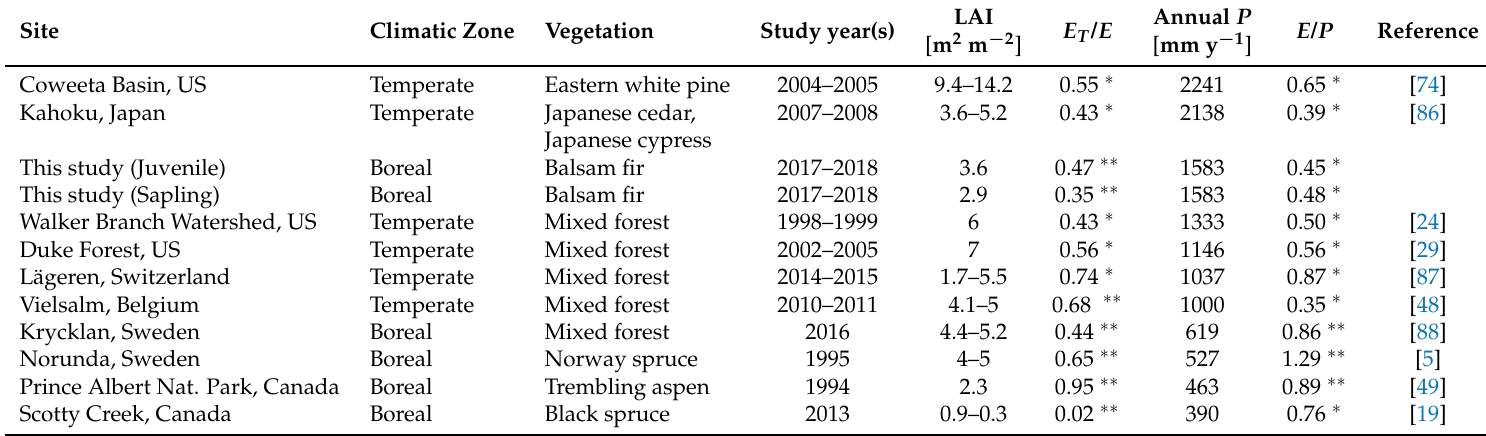
Table 2. Comparison of LAI, E T / E , annual precipitation ( P ) and evaporative index ( E / P ) between this study and several previous studies of E partitioning in boreal and temperate forests. Sites are ordered by annual precipitation rate, from the site receiving the most precipitation to the site receiving the less